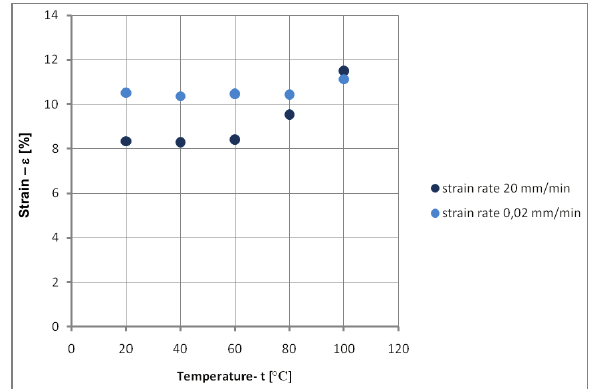
Fig. 4. Average value of tensile strain of woven geotextile at 20 mm/min and 0.02 mm/min strain rate and temperature from 20 to 100 ° C